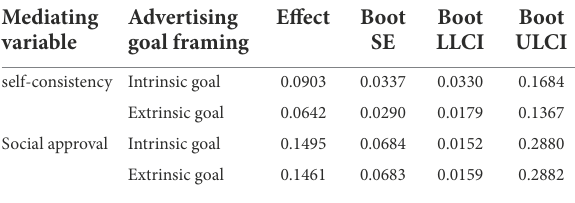
TABLE 4 Analysis of the mediating role of self-consistency and social approval.